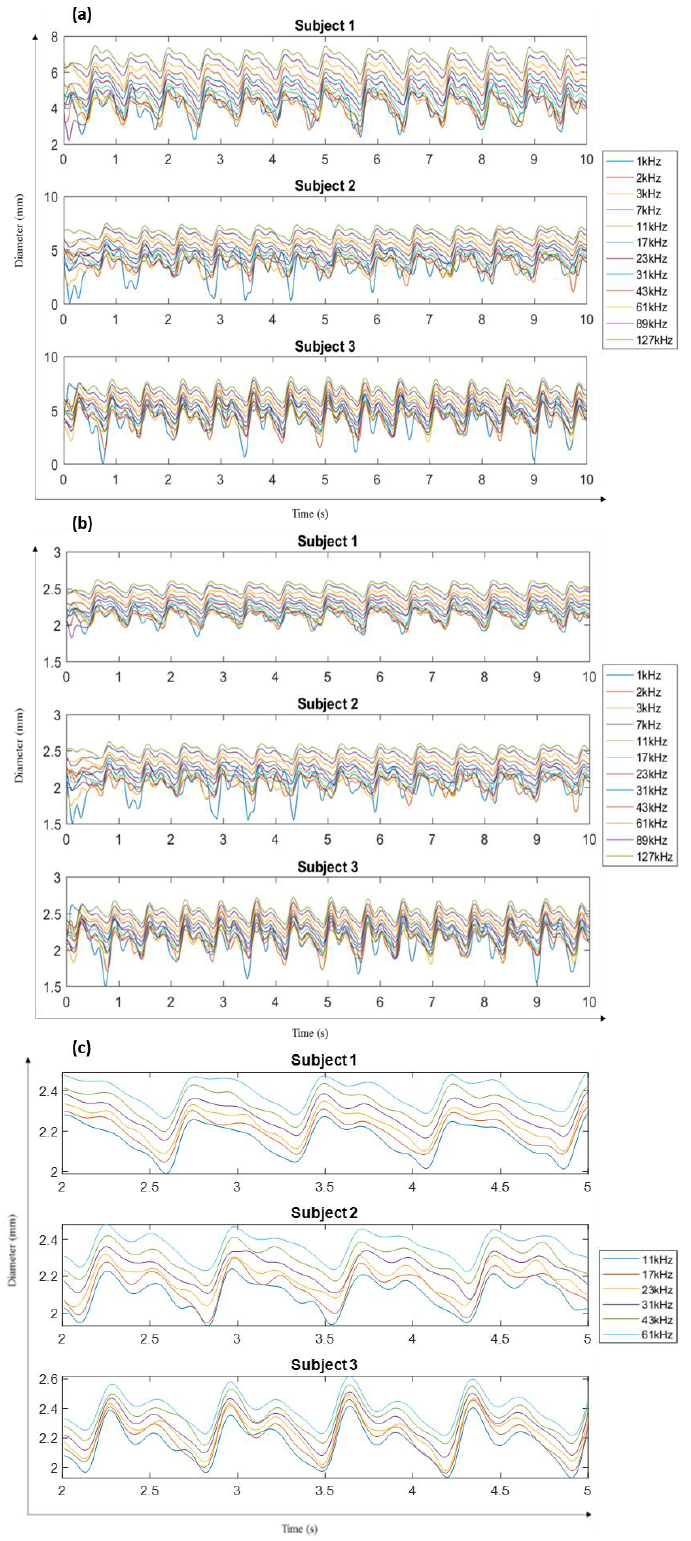
Figure 4. ( a ) Diameter waveforms calculated using impedance from (4) for each subject. ( b ) Modified diameter waveforms calculated using (6) for each subject. ( c ) 3 s section of modified diameter waveform calculated for each subject for frequencies within 11–61 kHz.